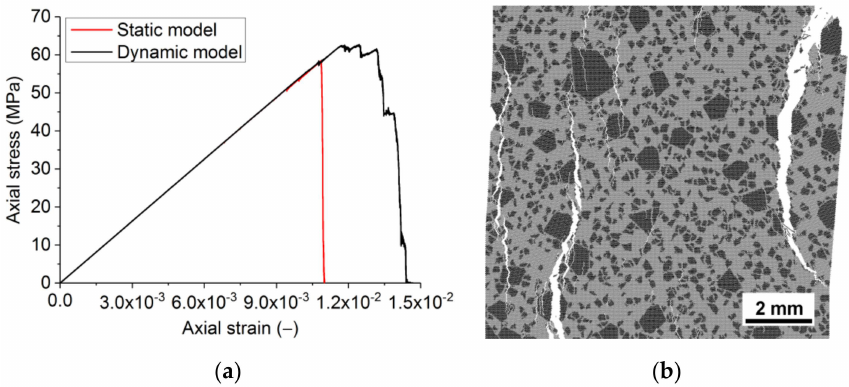
Figure 8. Compression diagrams obtained using the static and dynamic fracture models ( a ) and the broken sample in the dynamic fracture model ( b ). Strain rate 4 × 10 − 1 s − 1 .